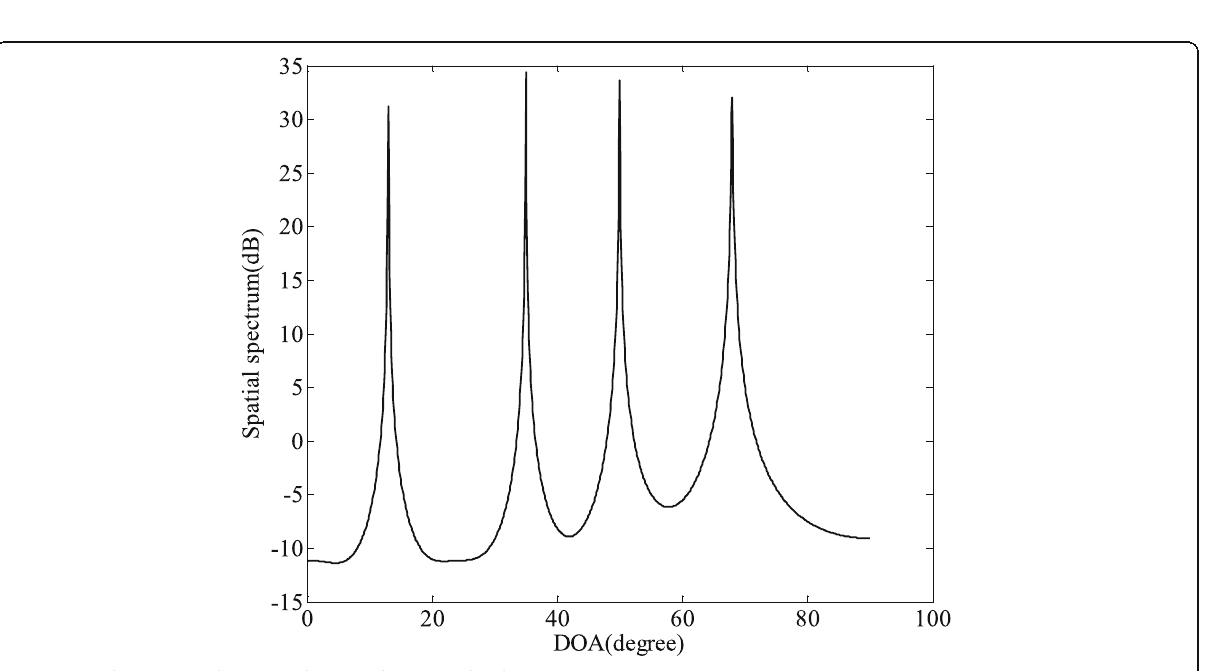
Fig. 6 Spatial spectrum when FS and NS are close to each